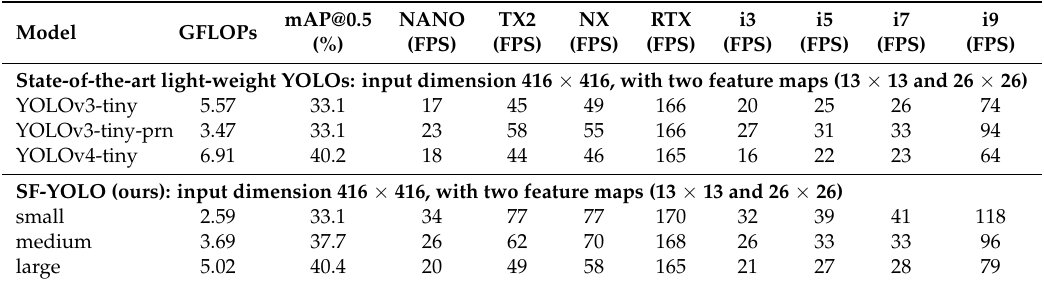
Table 3. Processing speed comparison with state-of-the-art light-weight YOLO detectors on the edge-computing devices by COCO test-dev2017